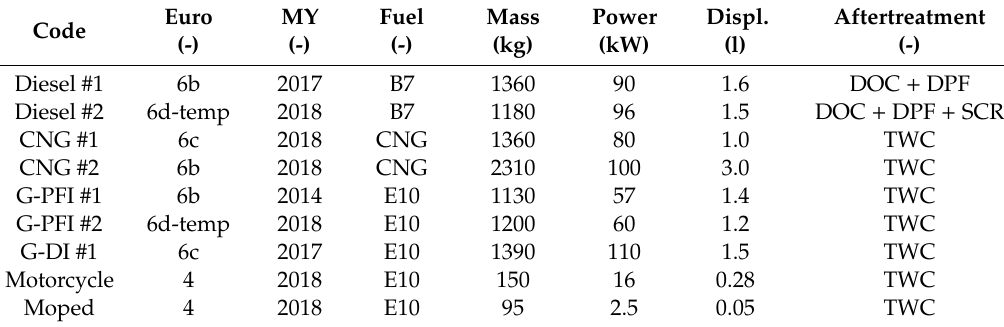
Table 2. Characteristics of the